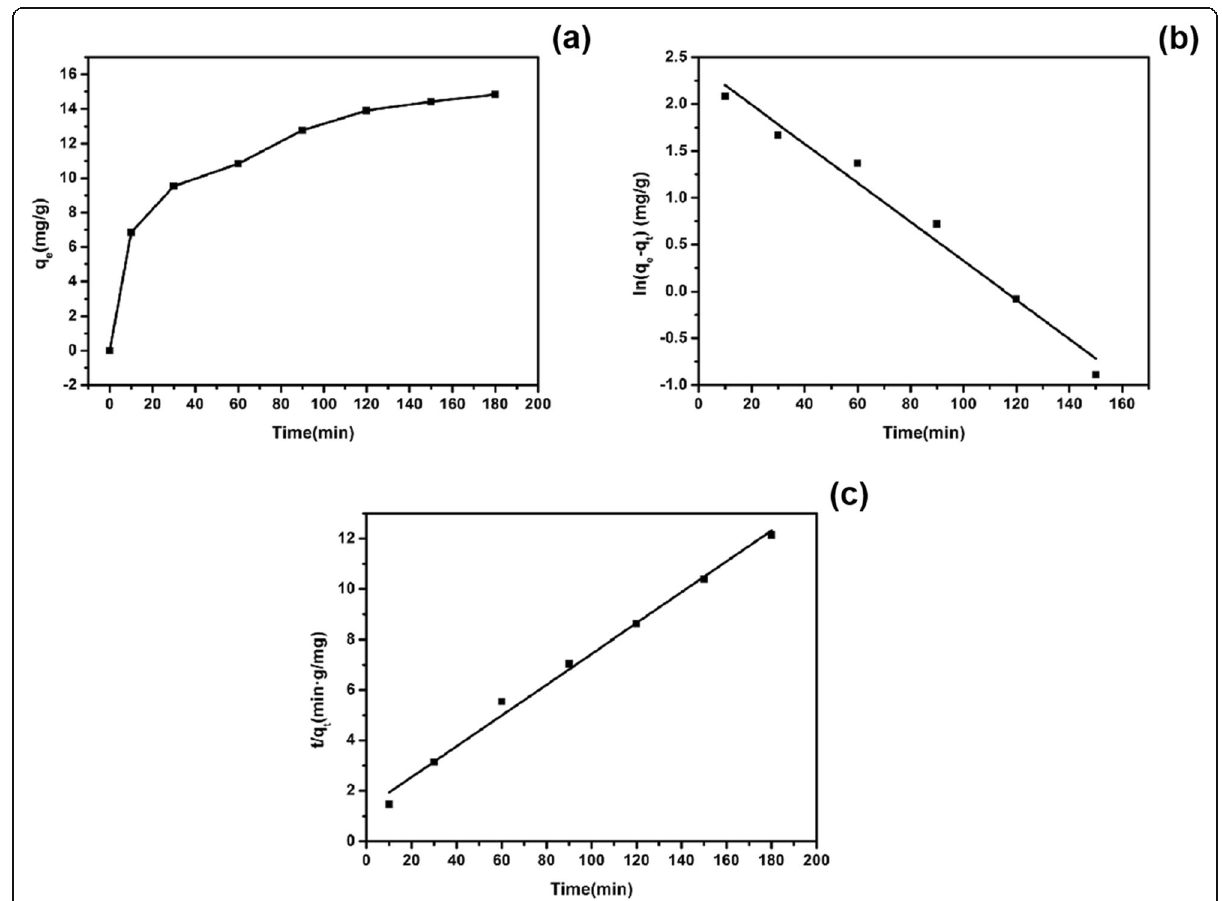
Fig. 12 Variation of copper sulfide adsorption with time ( a ), quasi-first-order kinetic model of copper sulfide adsorption EE2 ( b ), and quasi-